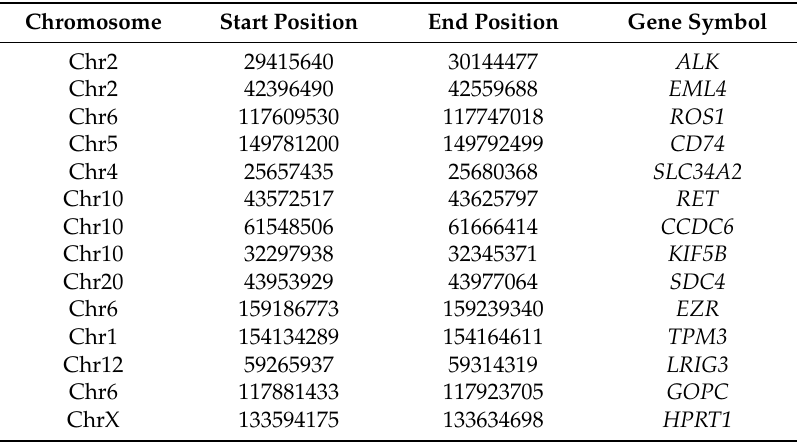
Table 1. Information of genes for gene fusion detection